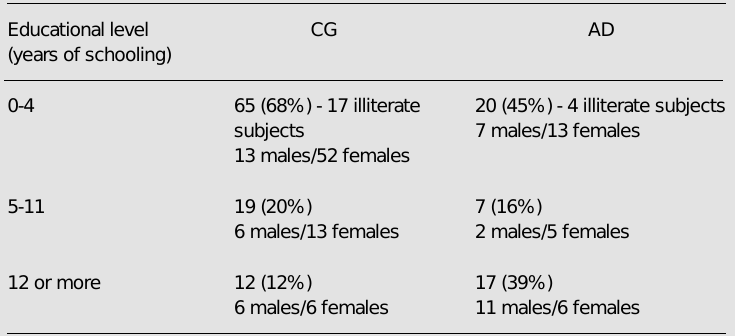
Table 1. Educational level for the control group and Alzheimer’s disease patients. Educational